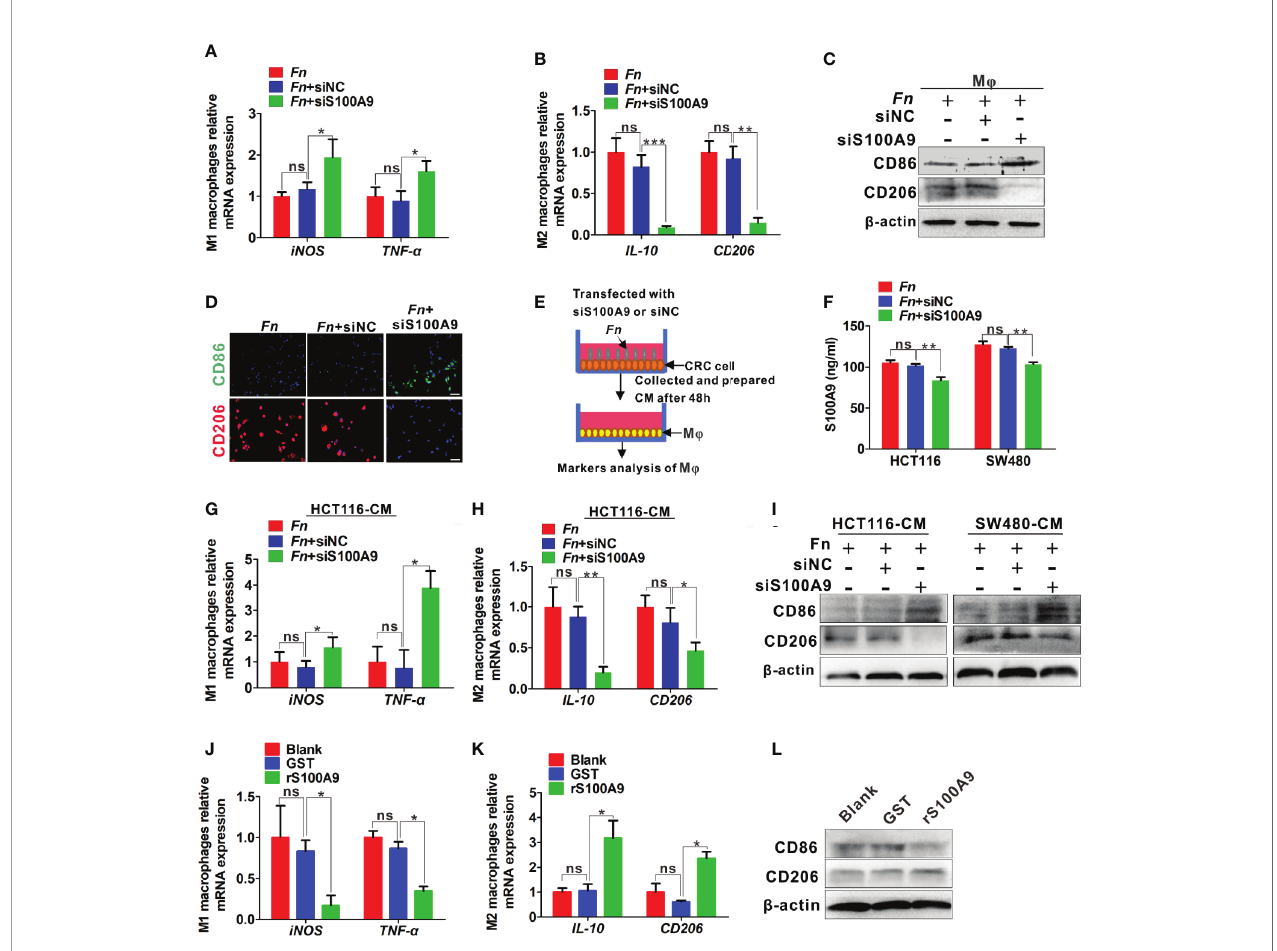
FIGURE 3 | S100A9 is involved in M2-like M j polarization in the presence of Fn in CRC. (A – C) M j s were transfected with siNC or siS100A9 and subsequently co- cultured with Fn . The levels of M1 markers and M2 markers in M j were detected by qPCR (A, B) and Western blot (C) . (D) Representative immuno fl uorescence images of CD86 + and CD206 + in M j infected with Fn and then transfected with siNC or siS100A9. CD86 was stained with Alexa Fluor 488 (green); CD206 was stained with Cy3 (red). Scale bars: 50 µm. (E, F) HCT116 and SW480 cells were transfected with siNC or siS100A9 and then infected with Fn . After 48 h, the supernatant of each group was collected and used to culture M j in the next experiment (E) . ELISA analysis for S100A9 expression in the supernatant of HCT116 and SW480 cells (F) . (G – I ) M j s were co-cultured with the CM from CRC cells. The levels of M1 markers and M2 markers in M j were detected by qPCR (G, H) and Western blot (I) . (J – L) M j s were treated with GST or rS100A9. The levels of M1 markers and M2 markers in M j were detected by qPCR (J, K) and Western blot (L) . Data were expressed as means ± SD in three independent experiments. ns, not signi fi cant. *p < 0.05; **p < 0.01; ***p <